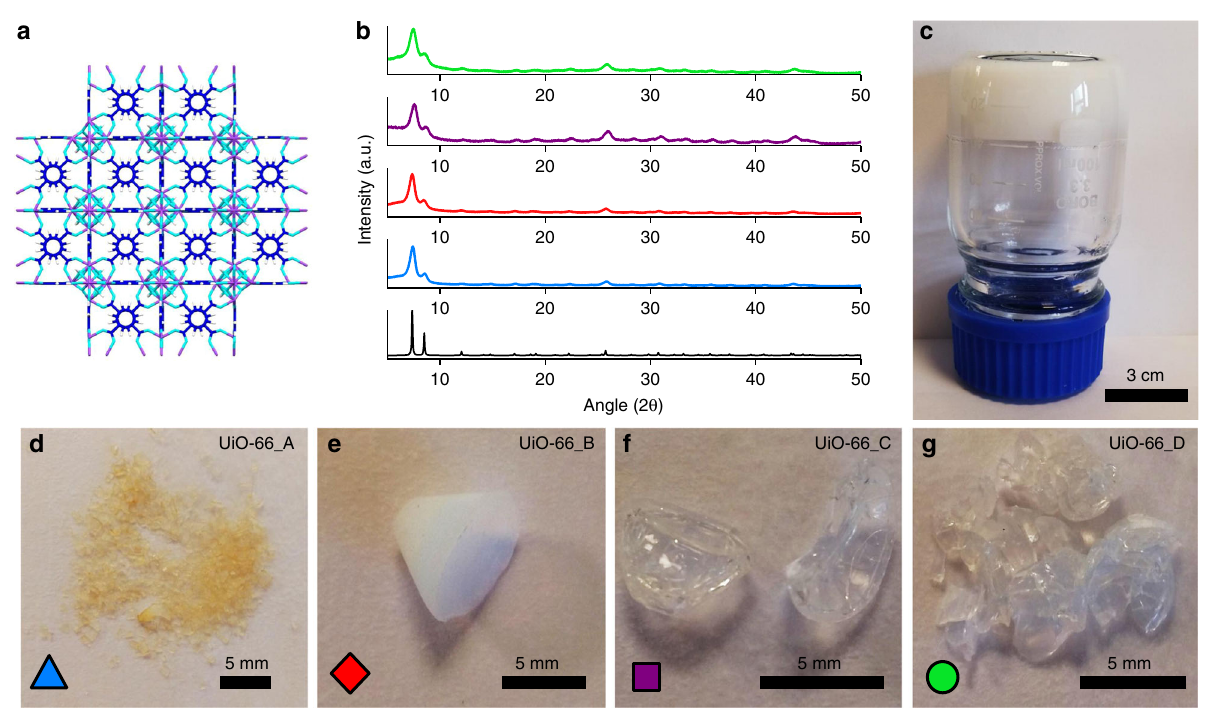
Fig. 2 Crystalline structure and optical images of UiO-66 gel and monoliths. a Graphical representation of the microporous crystal structure of UiO-66 with purple, sky blue, navy blue and white sticks representing zirconium, oxygen, carbon and hydrogen atoms, respectively. b Comparison of simulated XRD pattern of UiO-66 generated from its crystal structure; black, with PXRD patterns of mono UiO-66 samples ( mono UiO-66_A; blue, mono UiO-66_B; red, fi rming successful synthesis in each case. c UiO-66 gel used for synthesising monoliths. d UiO-66 mono UiO-66_C; purple, mono UiO-66_D; green) con washed in ethanol and dried at 200 °C ( mono UiO-66_A). e UiO-66 washed in ethanol and dried at 30 °C ( mono UiO-66_B). f UiO-66 washed in DMF and dried at 30 °C ( mono UiO-66_C). g UiO-66 washed in DMF with extended centrifugation and then dried at 30 °C ( mono UiO-66_D). d – g (lower left corner, inset), symbols used to represent each material in Figs. 4 and